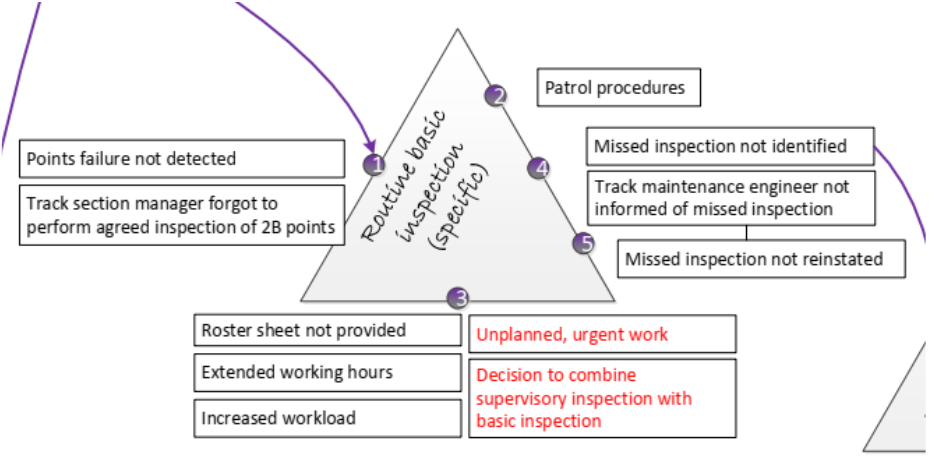
Figure 4. Graphical representation of one analysed function.